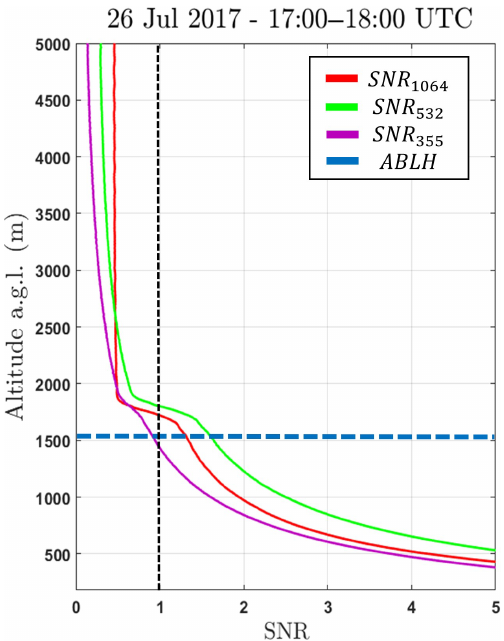
Figure 4. Signal-to-noise-ratio (SNR) profile of the three wave- lengths (1064nm, red line; 532nm, green line; and 355nm, violet line) obtained at 26 July 2017 between 17:00 and